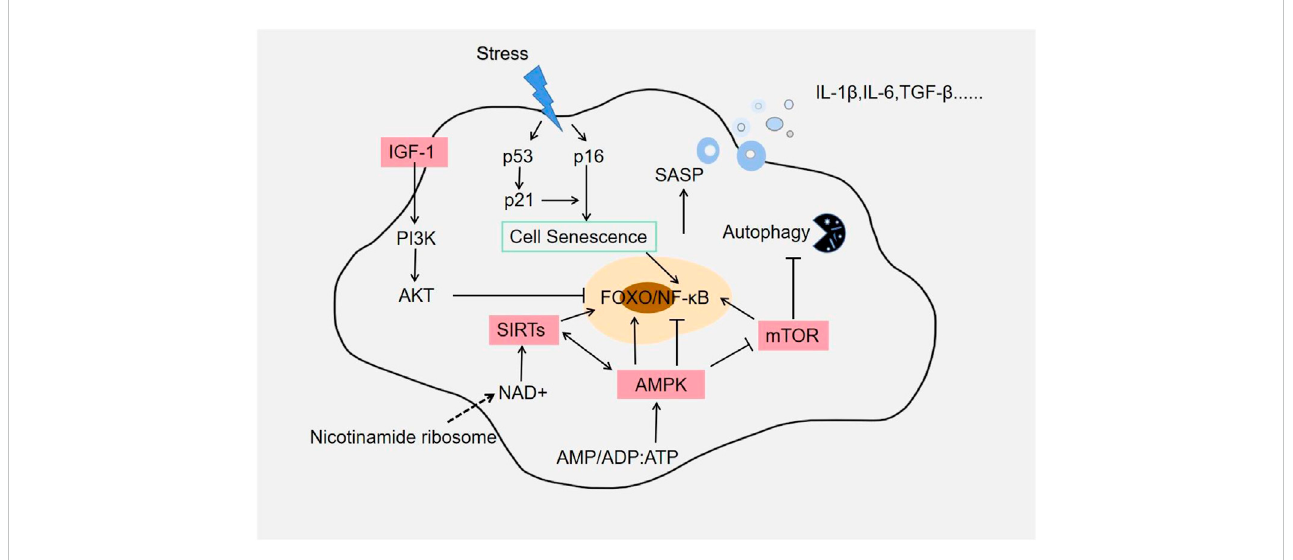
FIGURE 1 Aging-related signaling pathways. Most pathways establishing the SASP phenotype appear to converge on activation of the NF- κ B and FOXO pathways. Rapamycin(mTOR)pathwayisalsoanimportantnodeinSASPregulation,anditisakeyroleintheagingprocess.Eliminationofsenescentcellsreducesmany pro-in fl ammatoryfactors,suchasIL-6,IL-1 α ,andTNF- α .Autophagyisamajorlysosomaldegradationpathway,andCRactivatesautophagyandmayactasan anti-aging agent by removing damaged proteins and organelles such as